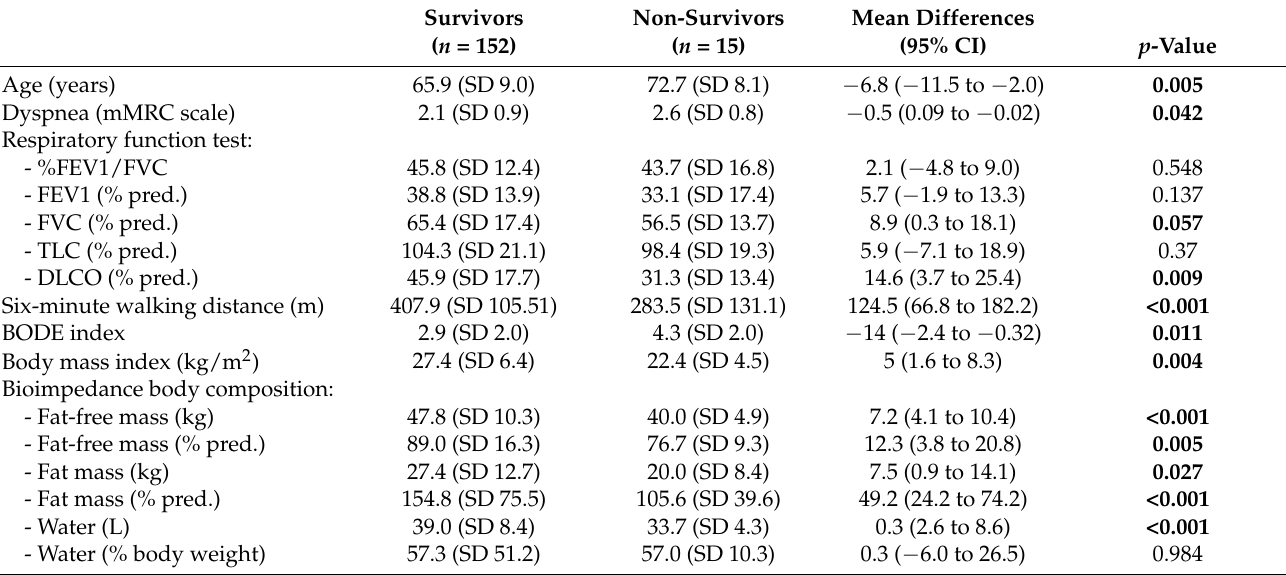
Table 3. Main clinical differences between survivors and non-survivors at 2-year follow-up. Survivors Non-Survivors Mean